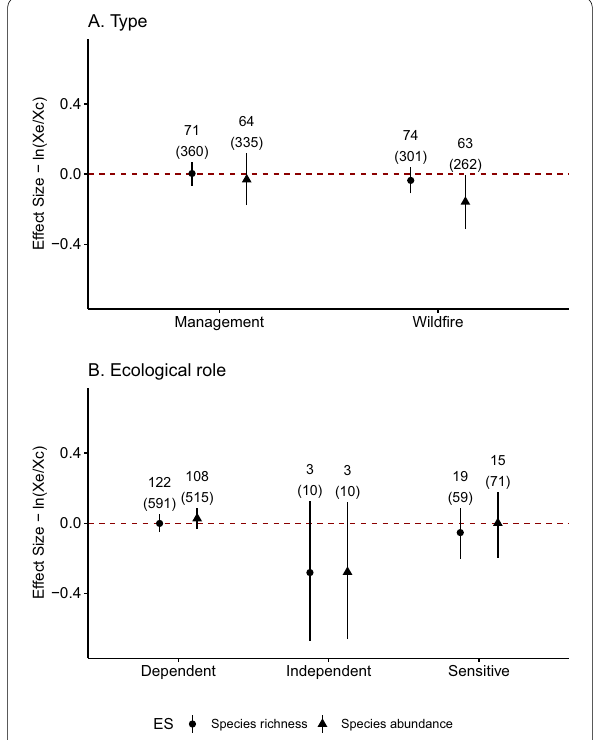
Fig. 3 Effect of fire type ( A ) and ecological role ( B ) on species richness and abundance. The circles represent the richness of species, and the triangles the abundance. The length of the lines represents the 95% confidence intervals. Numbers above dots represent the number of studies and, within parenthesis, the number of studied pseudo‑replicas pooled to estimate the effect sizes